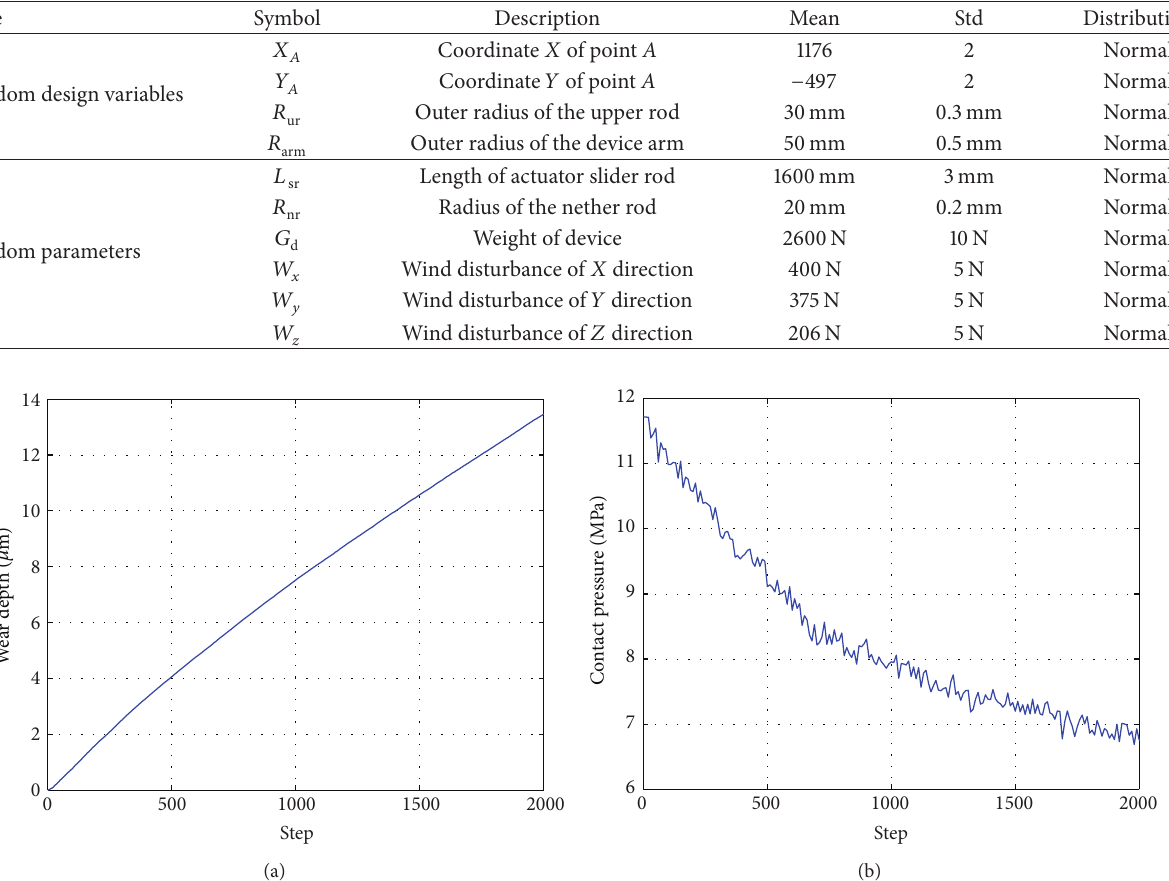
Figure 7: Time-dependent responses of wear depth and contact pressure. (a) Wear depth curve during the service life; (b) contact pressure curve during the service